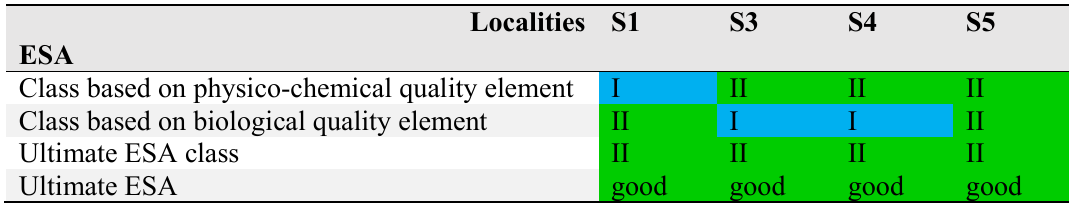
Table 4. Ecological status assessment (ESA) of the Samokovska River based on physico-chemical and biological quality elements in October 2018 (water body Type 6).